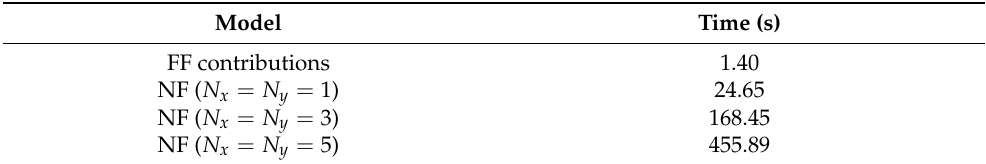
Table 2. Computational performance of each algorithm in the computation of the near field in a total of 22,500 points employing an Intel i9-9900 CPU working at 3.1 GHz. Computations are parallelized with OpenMP [30].